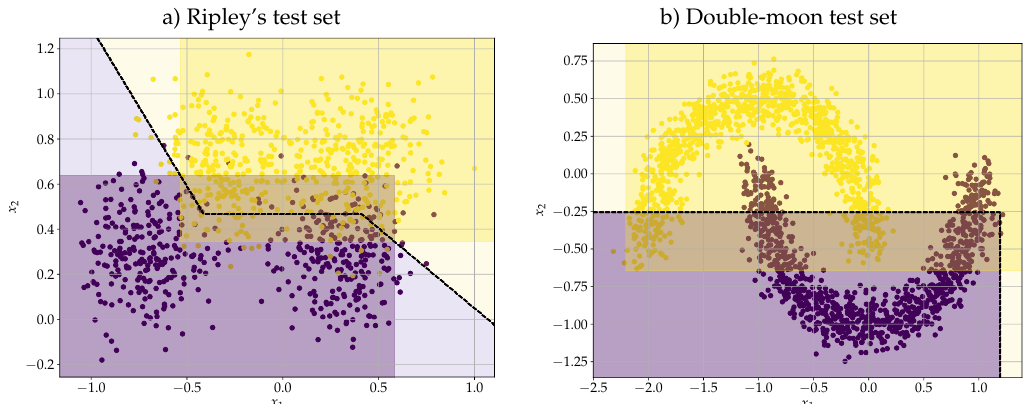
Figure 2. Performance of the dilation-erosion perceptron (DEP) classifier on Ripley’s and double-moon datasets described on Examples 4 and 5. Scatter plot of test data and the decision boundary of DEP classifier. The purple and the yellow regions corresponds respectively to the sets D ( w ) and E ( m )